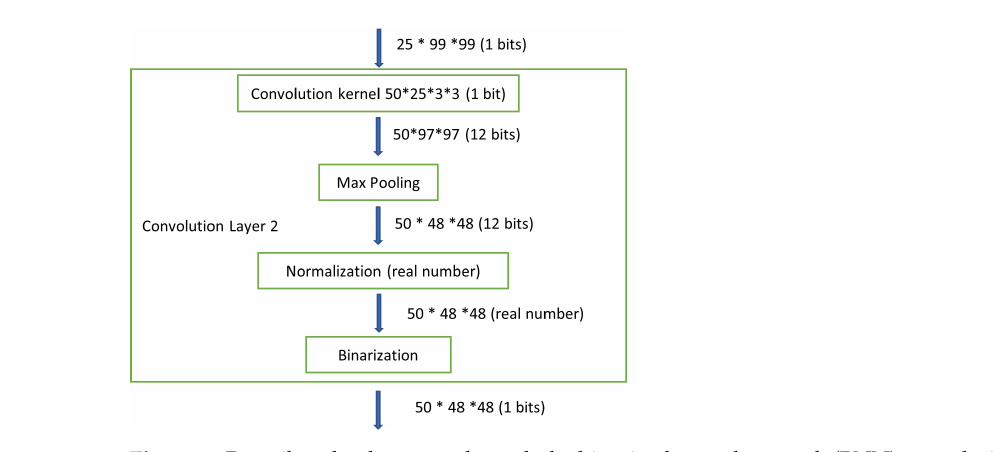
Figure 4. Describes the data type through the binarized neural network (BNN) convolutional layer 2.